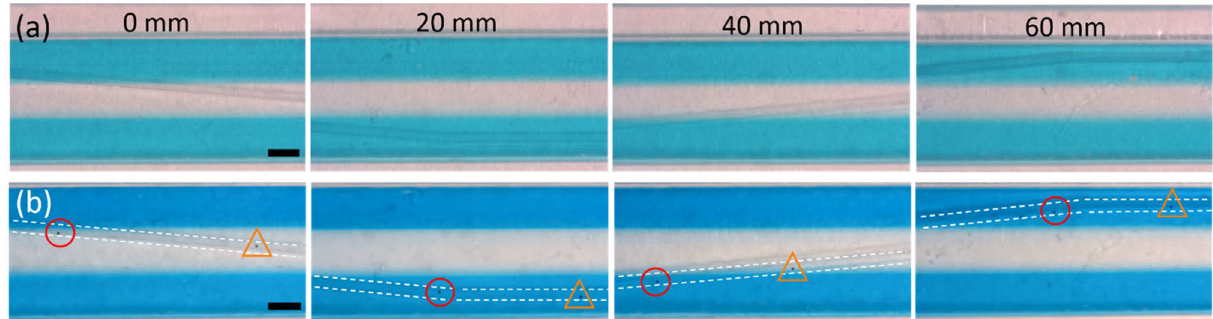
Figure 9. ( a ) Optical microscopy picture of ( a ) the channel at different positions in the chip; ( b ) the particles following the rail in the first zig-zag. Side liquids: EtOH with blue dye, middle liquid: EtOH. All three liquids are introduced at liquid velocity of 25 mm s −1 . Scale bar is 1